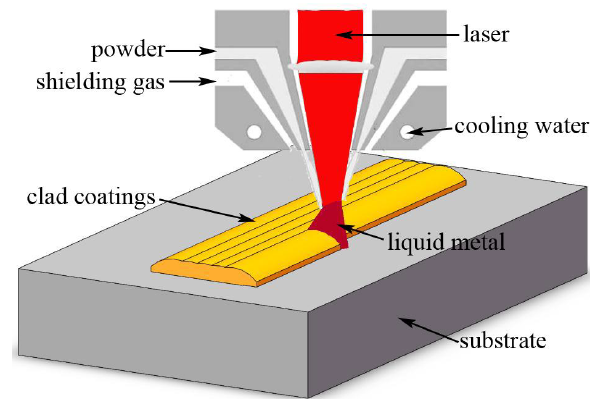
Figure 2: The schematic diagram of laser cladding with coaxial powder feeding